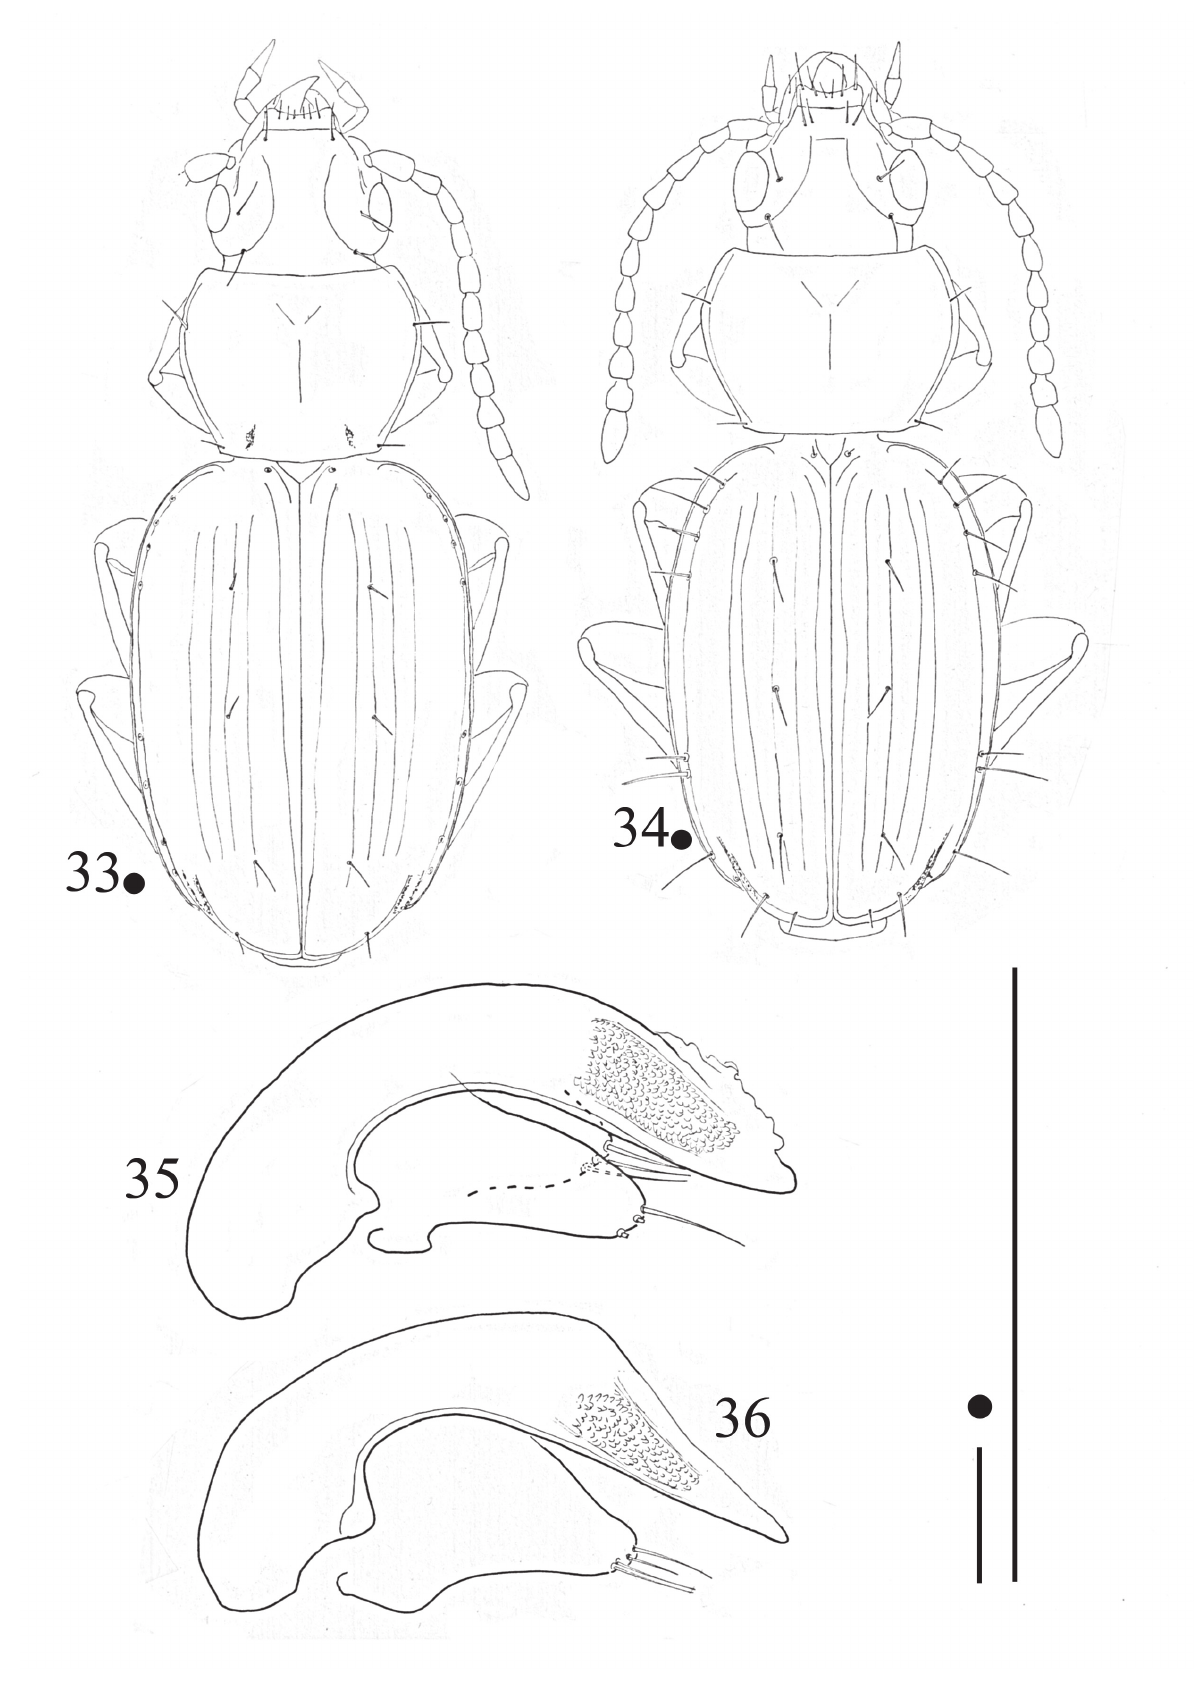
Figs 33-36. Habitus (33, 34) and aedeagus in lateral view (35, 36) of Tasmanorites spp.: 33, 35) T. nitens (Putzeys), LT ♂ from Tas- mania; 34, 36) T. lynceorum sp. nov., HT ♂ from Mt. Wellington. Scale: 0.5